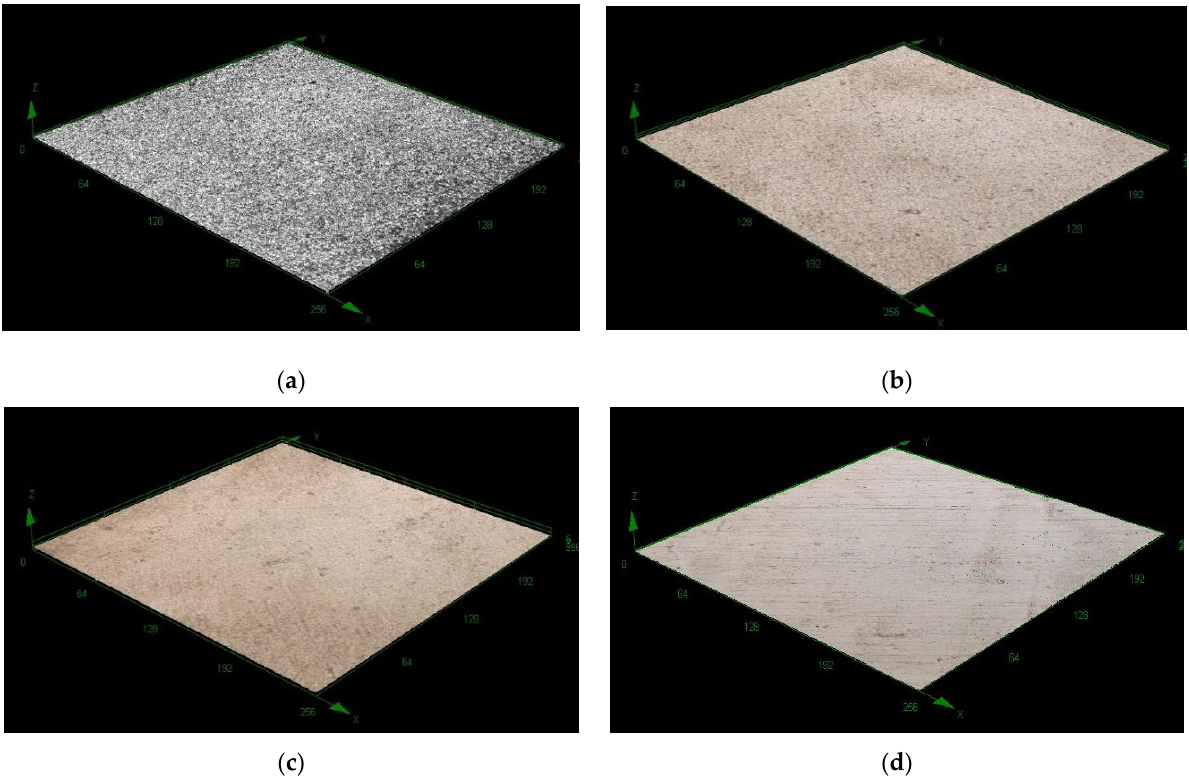
Figure 8. Images for copper ( a , b ) and nickel electrodeposition ( c , d ) without/with 10 −4 mol L −1 CZ, magnification: 50×.